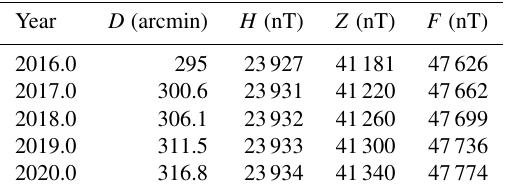
Table 2. a 1 coefficients of the Bulgarian Geomagnetic Reference Field from 2016 to 2020 for each field element H , D , Z , and F